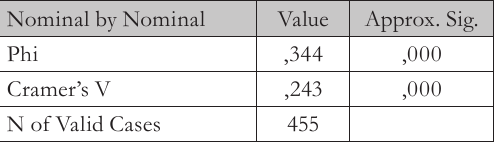
Tab. 11 - Analysis of the corporate sustainability and capital structure. Source: own Nominal by Nominal Value Approx. Sig. Phi ,344 ,000 Cramer’s V ,243